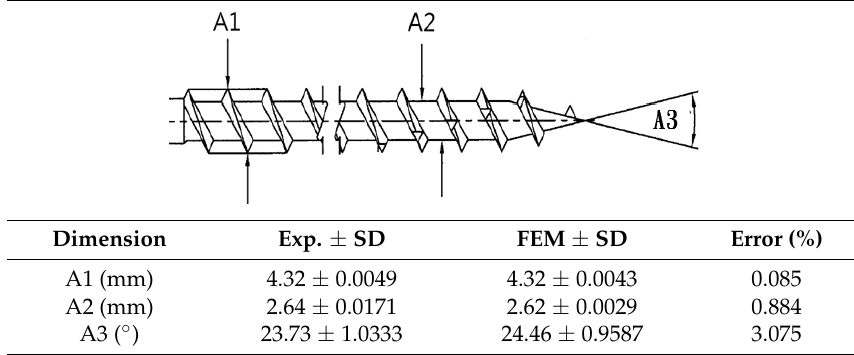
Figure 16. Effective stresses of flat dies and workpiece for cross-section of Figure 15. Table 2. Comparison of dimensions of simulated and actual products. Table 2. Comparison of dimensions of simulated and actual